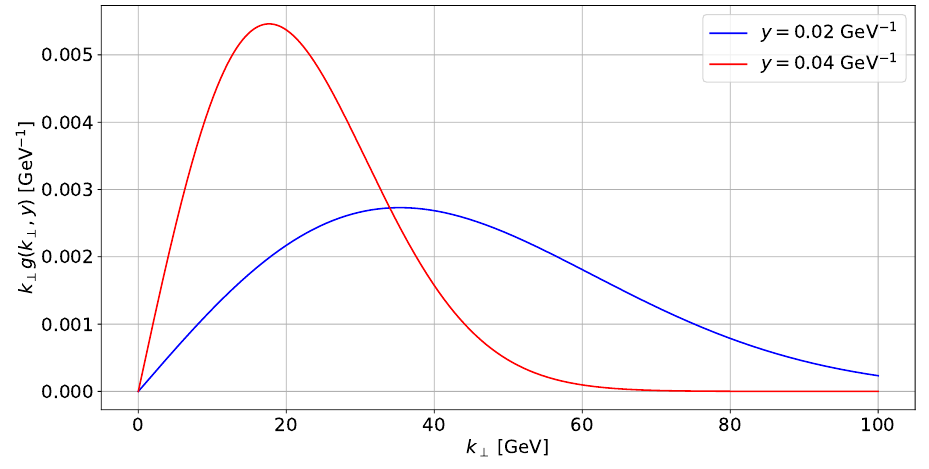
Figure 4 . Plot of the distribution k ? g ( k ? ; y ) as a function of k ? for y = 0 : 02 GeV (cid:0) 1 and y = 0 : 04 GeV (cid:0) 1 . Here, (cid:12) = 1 is